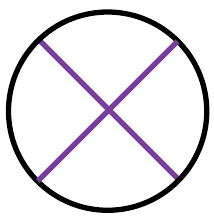
Figure 8. Contact Witten diagram contributing to (cid:12) 2 , after integration in d d x